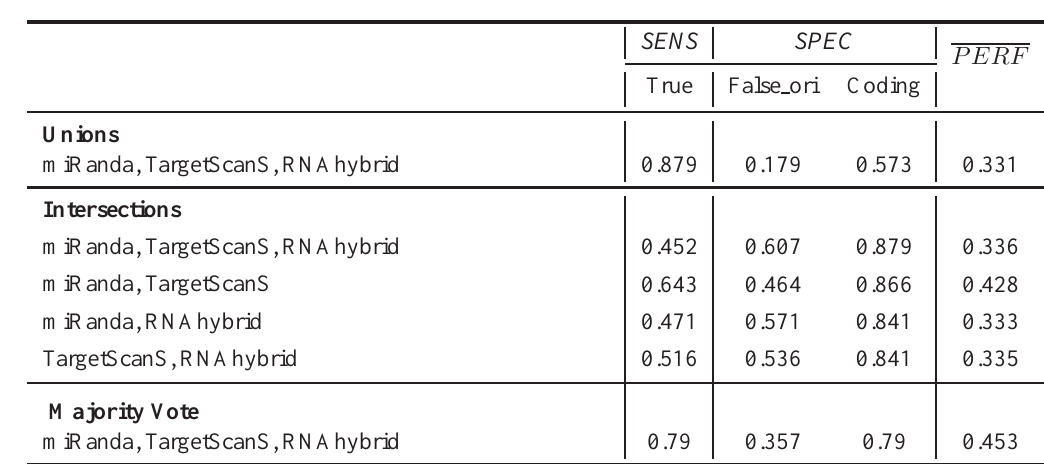
Table 3: Performance of various unions and intersections of the individual algorithms.